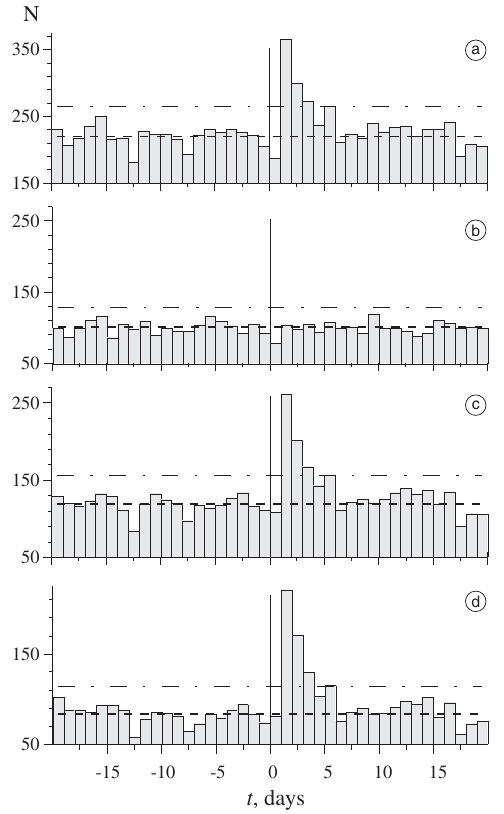
Fig. 1a-d. Daily number of earthquakes in the area of the Northern Tien Shan and adjacent territories be- fore ( t < 0) and after ( t > 0) the MHD-generator runs on the Bishkek test site plotted against time: a) for the entire area, b) its northern and (c) southern (North Tien Shan) part, d) events occurring in the up- per 5 km layer of the southern part of the region. The vertical axis shows the daily rate of earthquakes; hor- izontal axis shows the time measured from the MHD start-ups (in days). The dashed lines indicate a mean background level (lower lines) and 99% confidence interval (upper